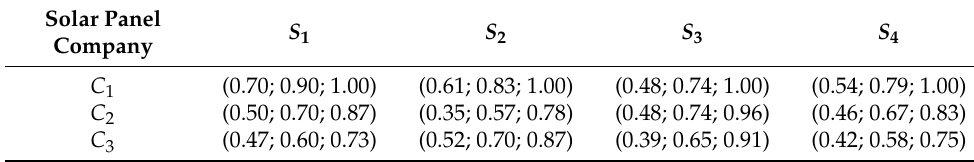
Table 14. Fuzzy normalized decision matrix for M 3 .